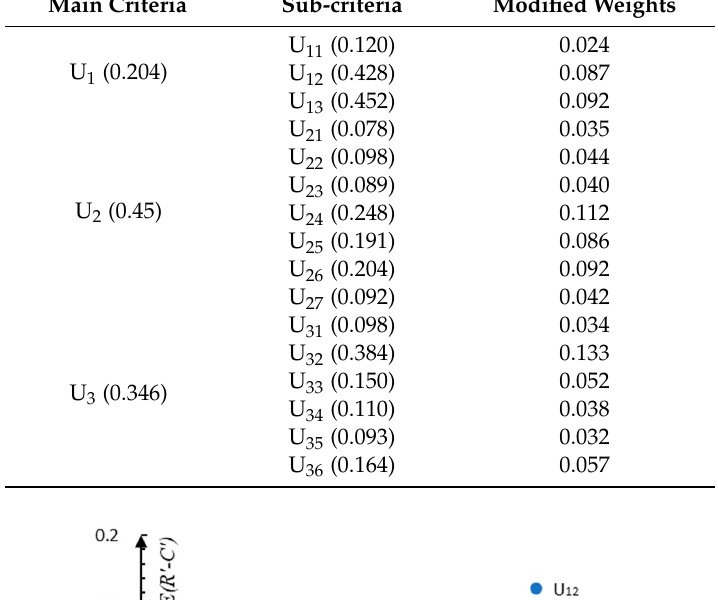
Table 17. The modified weights of evaluation criteria.